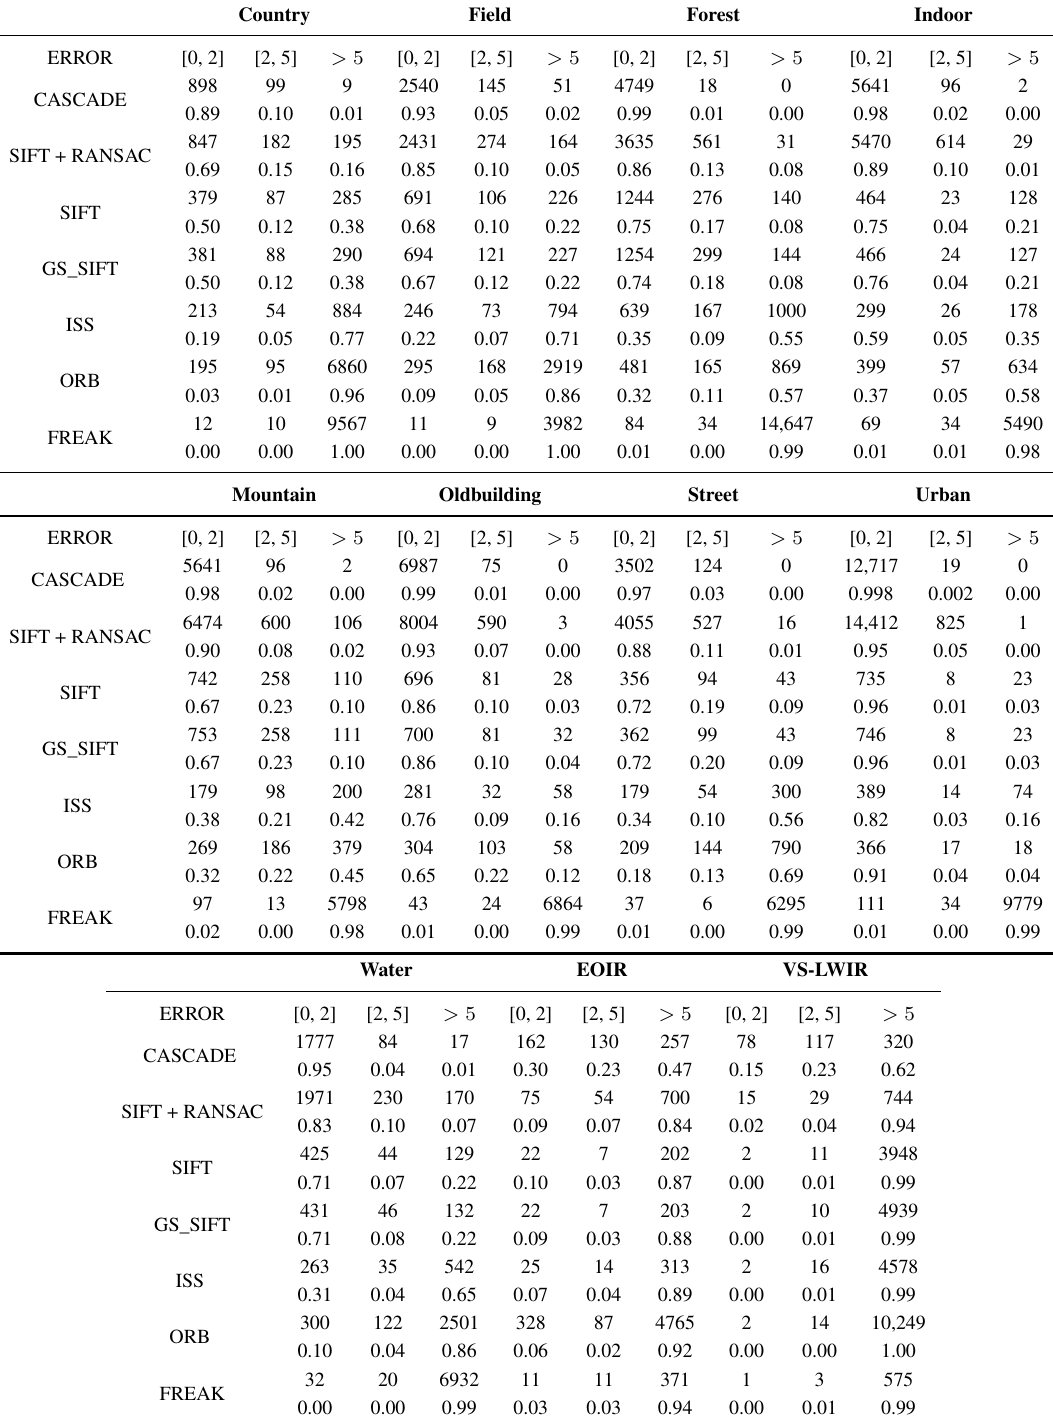
Table 1. The error distribution